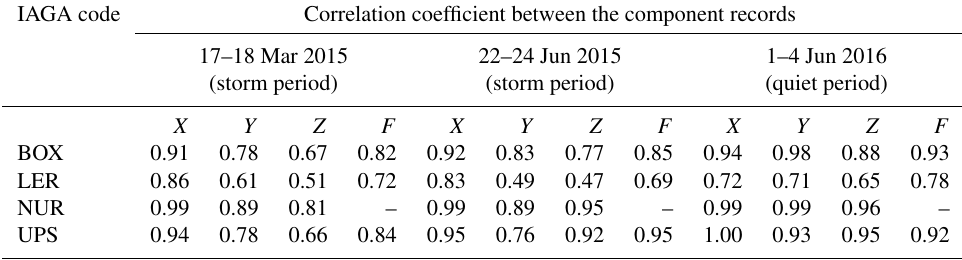
Table 2. Correlation coefficients for the magnetic field components from SPG and other observatories during the periods of disturbed (17–18 March and 22–24 June 2015) and quiet magnetic field (1–4 June 2016). IAGA code Correlation coefficient between the component